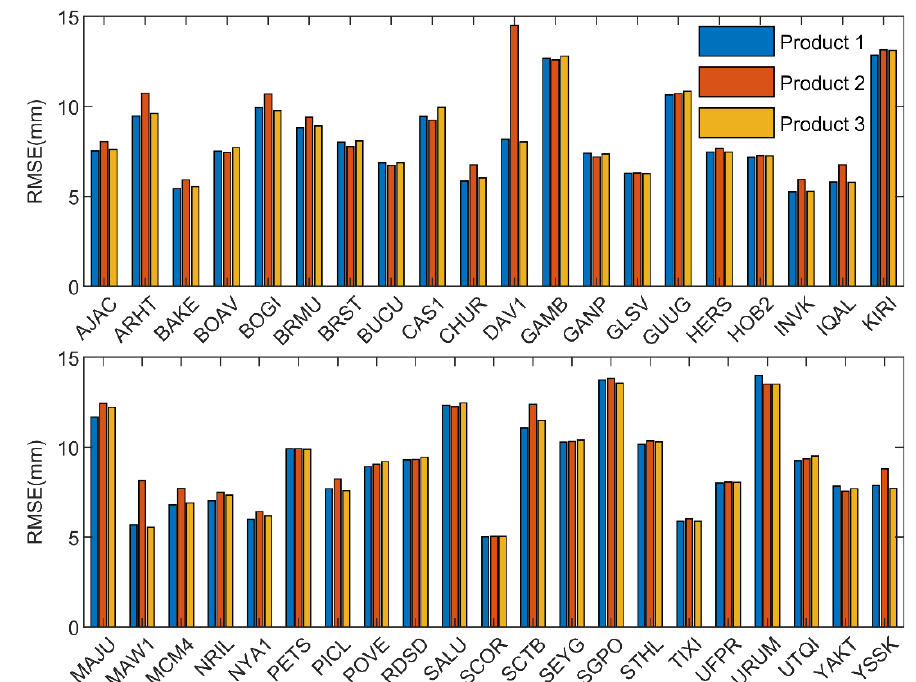
Figure 6. RMSE of the ZTDs estimated from PPP of 154 days in 2020 resulting from three VMF forecasting products at each of the 41 selected IGS stations.